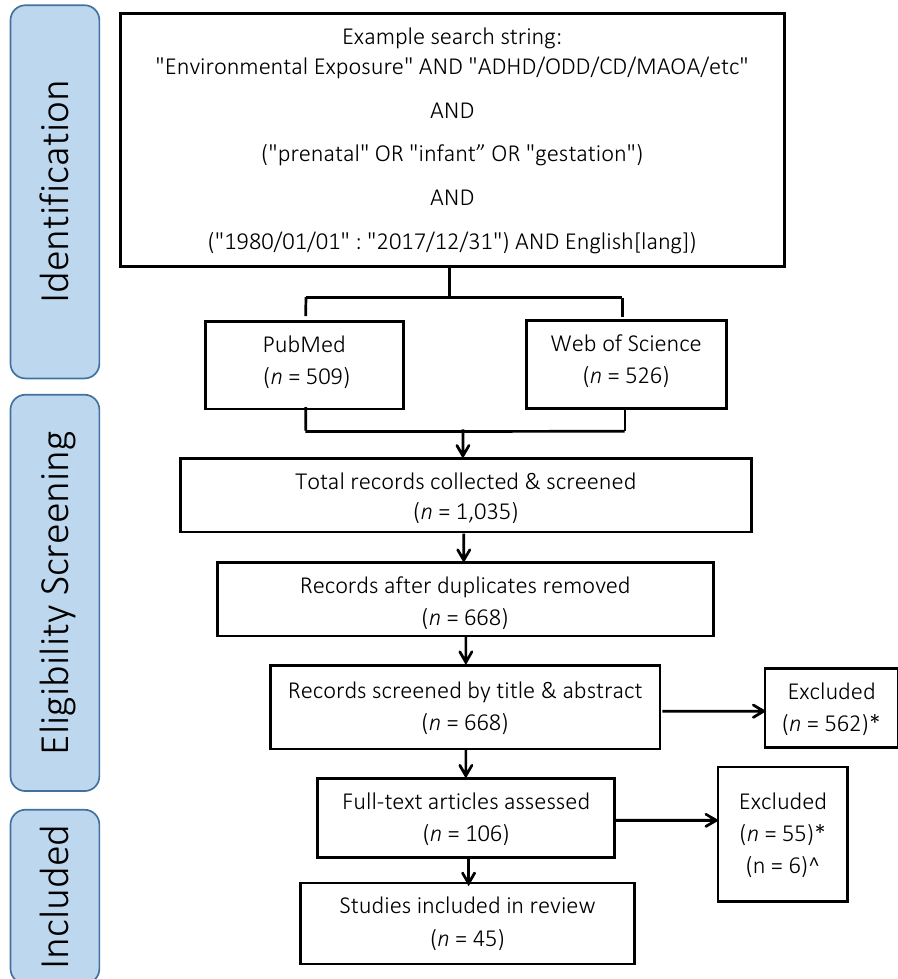
Figure 1. PRISMA diagram of the reference selection process for this review.